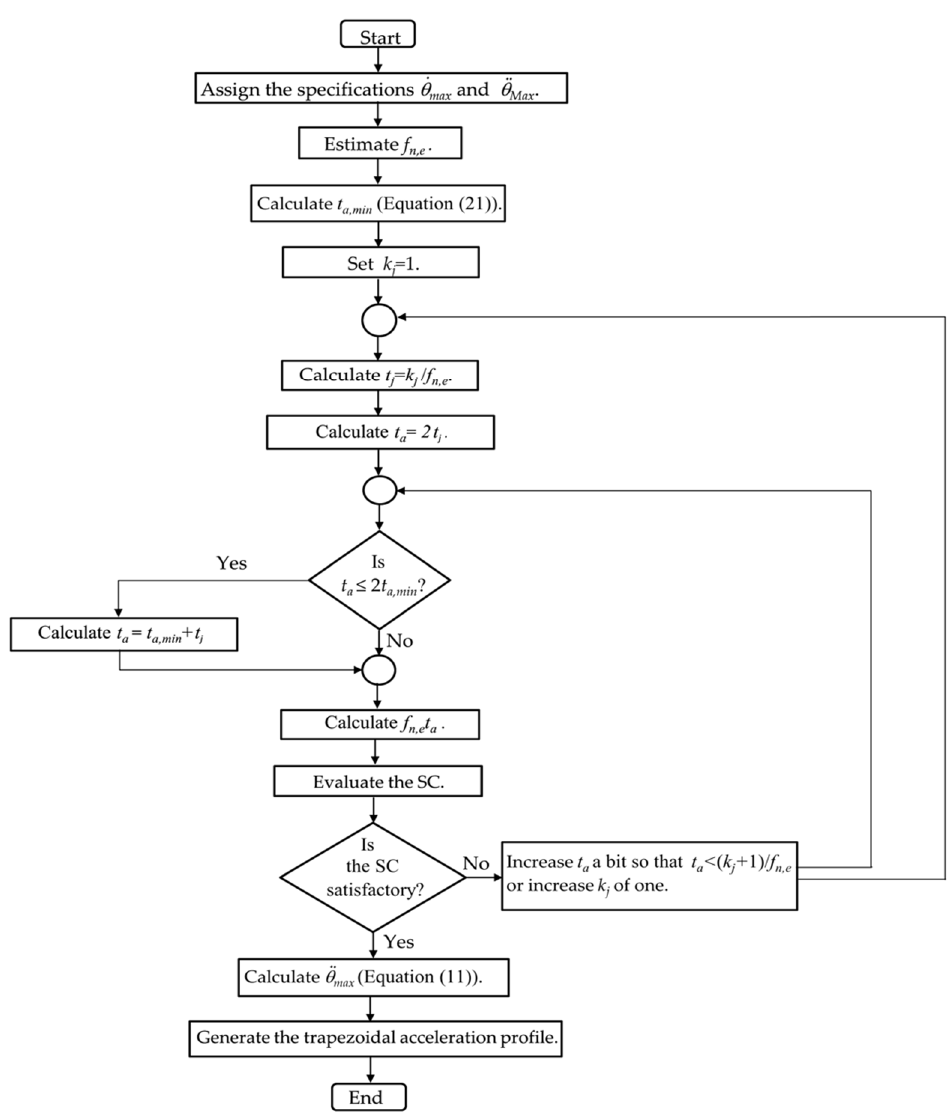
Figure 25. Flowchart of the procedure to design the STAP of the motor.